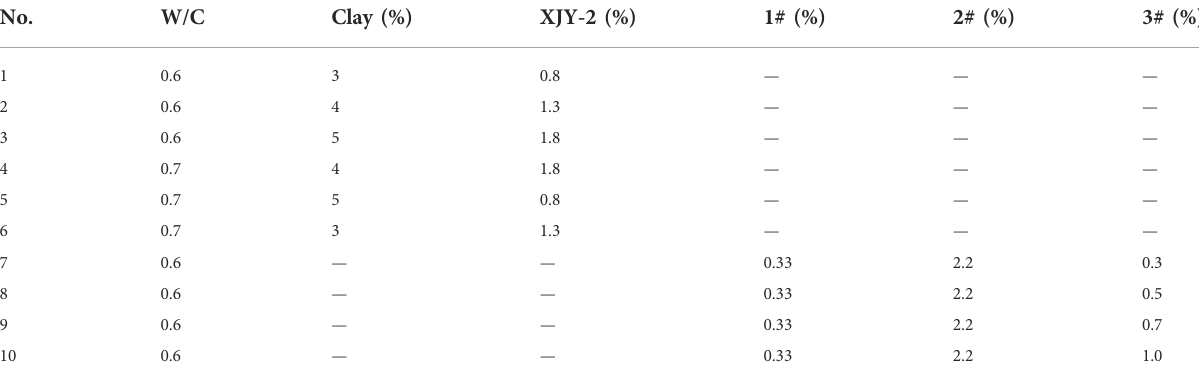
TABLE 2 Composition of the